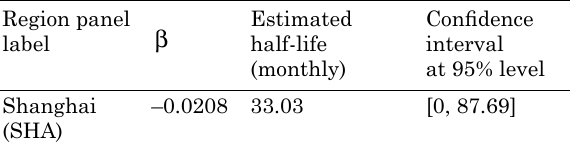
Table 4. Estimated half-lives and confidence intervals Region panel label